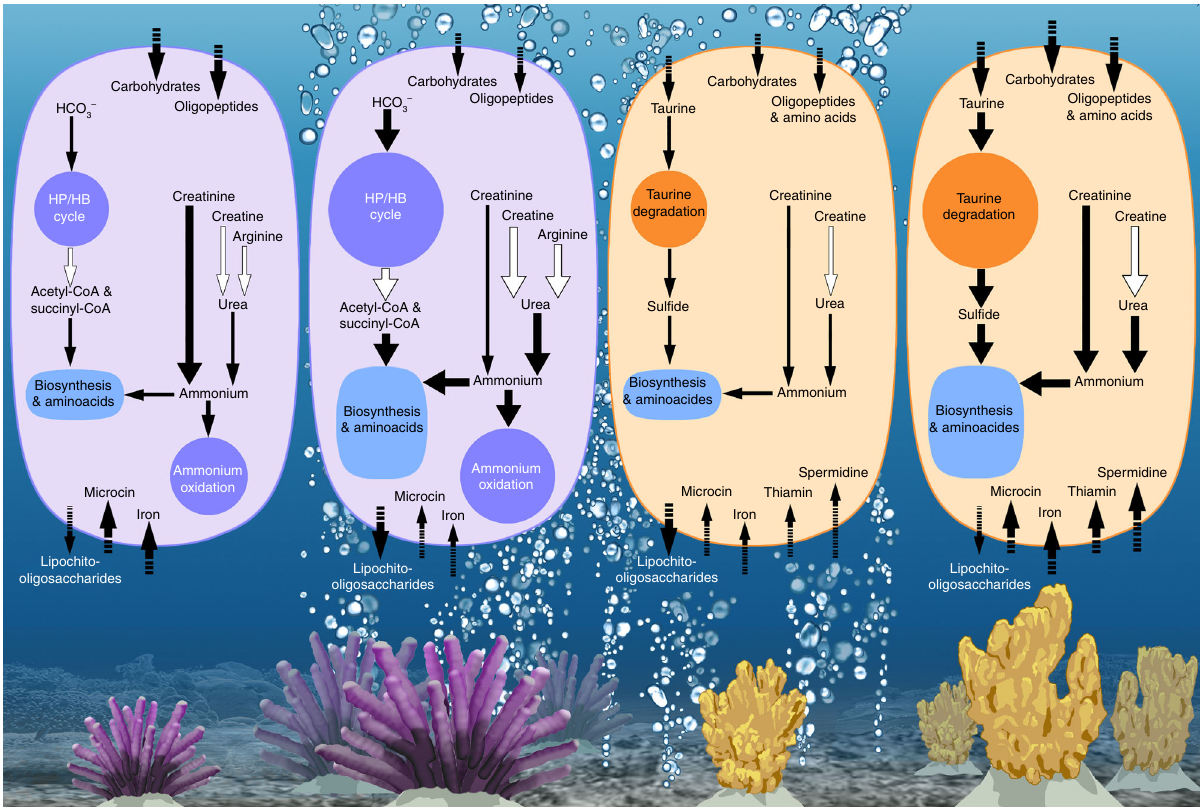
Fig. 4 Schematic summary of the functions affected by the CO 2 seep in microbiomes of C. singaporensis (represented in purple) and S. fl abelliformis (represented in